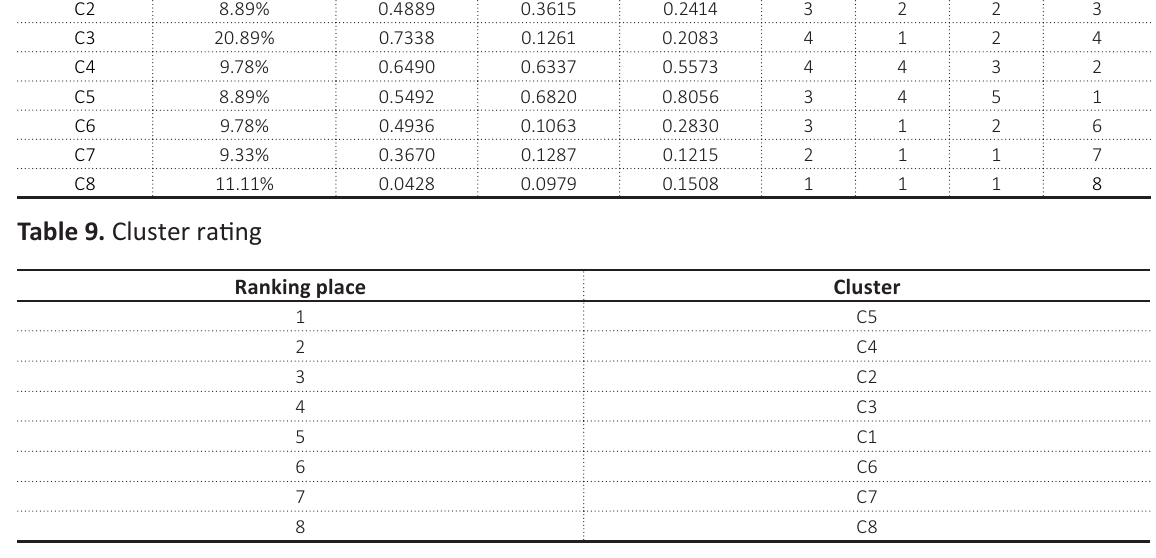
Table 10. Assessment of financial intermediaries by groups within clusters Cluster Financial intermediary evaluation Group